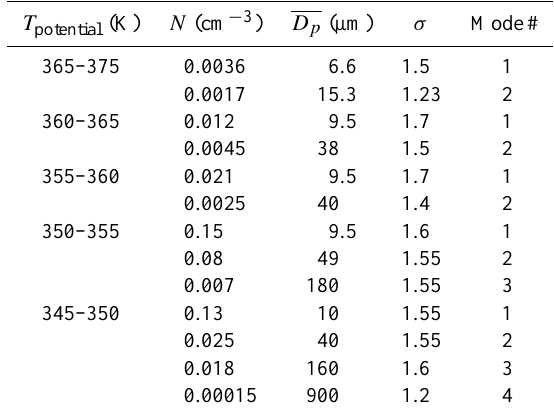
Table 2. Parameters as defined in Eq. (2) for the two to four modal lognormal size distributions fitted to the median size distribution for each temperature bin as shown in Fig.